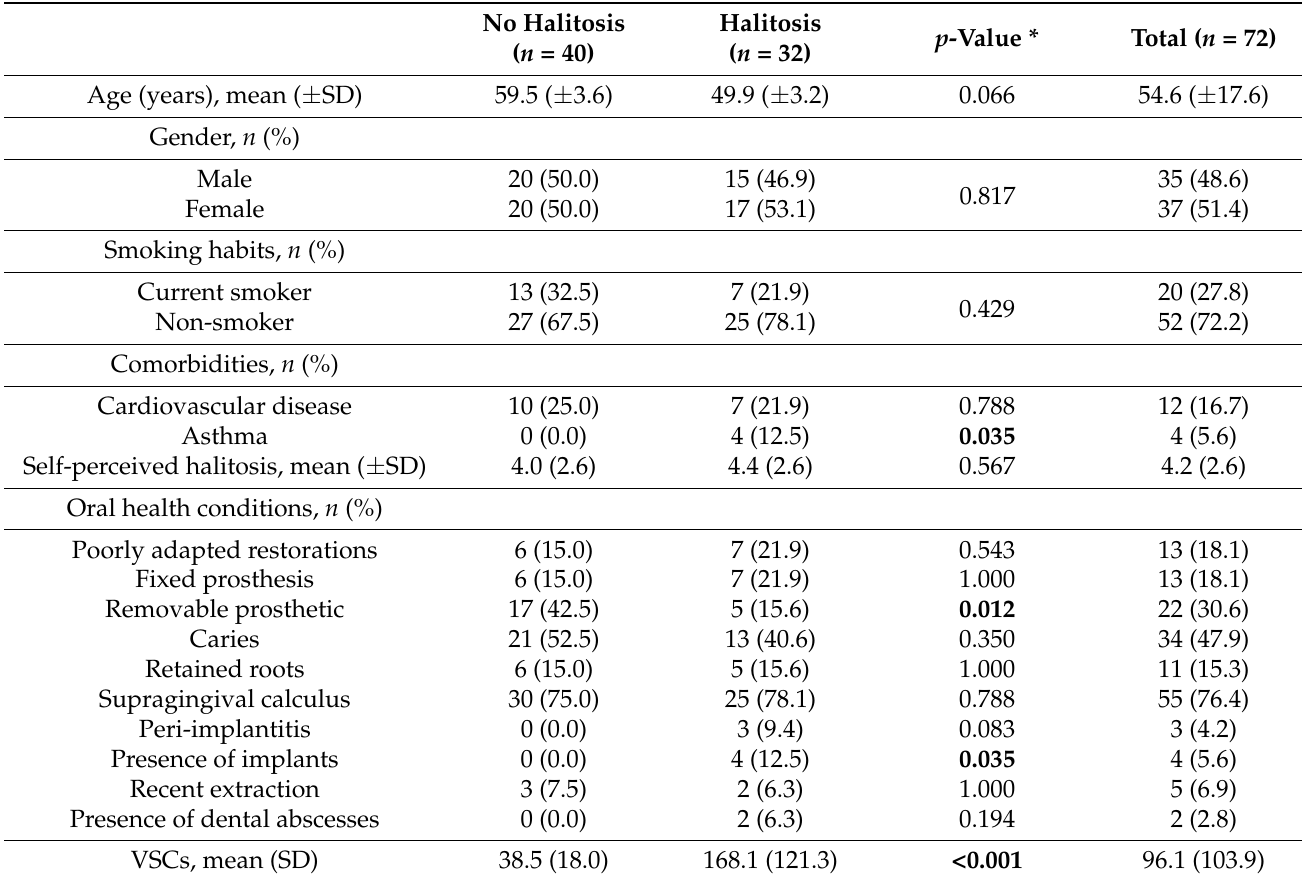
Table 1. Participants’ characteristics, stratified according to halitosis